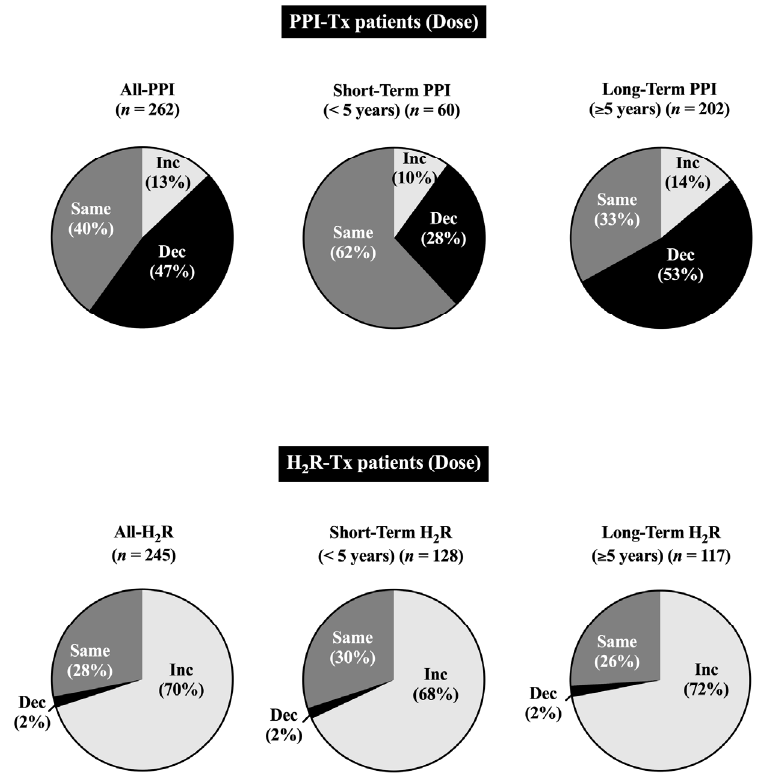
Figure 2. Pie charts showing distribution of changes in drug dosage with short- (<5 yrs) or long-term ( ≥ 5 yrs) treatment with either a histamine H 2 -receptor antagonist or proton pump inhibitor. Data shows the percentage of ZES patients treated with either a histamine H 2 -receptor antagonist or proton pump inhibitor at any time, during short-term (<5 yrs) or long-term ( ≥ 5 yrs) treatment, who required an increase in daily drug dosage, no dosage change, or a decrease in dosage deter- mined as described in the Materials and Methods section. For PPI users, the mean time between the first and last dose for the total was 9.78 ± 0.35 years, the mean time for the short-term treatment group was 2.45 ± 0.17 years, and the mean time for the long-term treatment group was 12.00 ± 0.32 (range 5.2-32.2) years. For H 2 R users, the mean time from first to last dose time for all users was 6.38 ± 0.32 years, the mean time of the short-term treatment group was 2.32 ± 0.13 years, and the mean time of the long-term treatment group was 10.86 ± 0.50 (range 5.0-29.2) years. Abbreviations: Inc.: increased dose, Dec.: decreased dose.